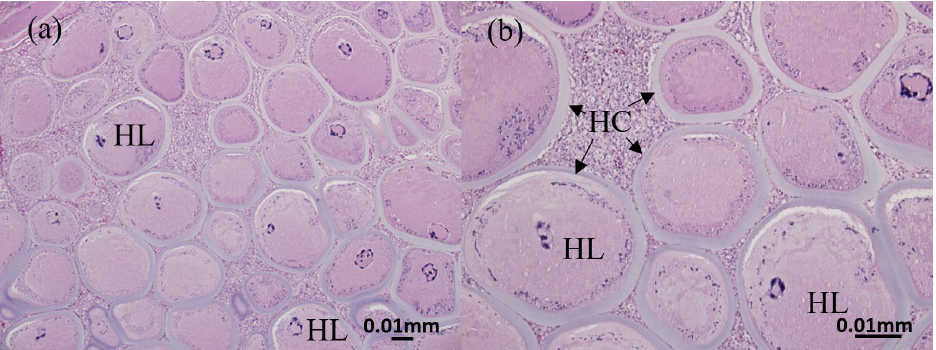
Figure 3. Histopathological findings of hypertrophic lymphocystis cells. ( a ) 40× view and ( b ) 40× view. HL: hypertrophic lymphocystis cell; HC with arrow: hyaline capsule.